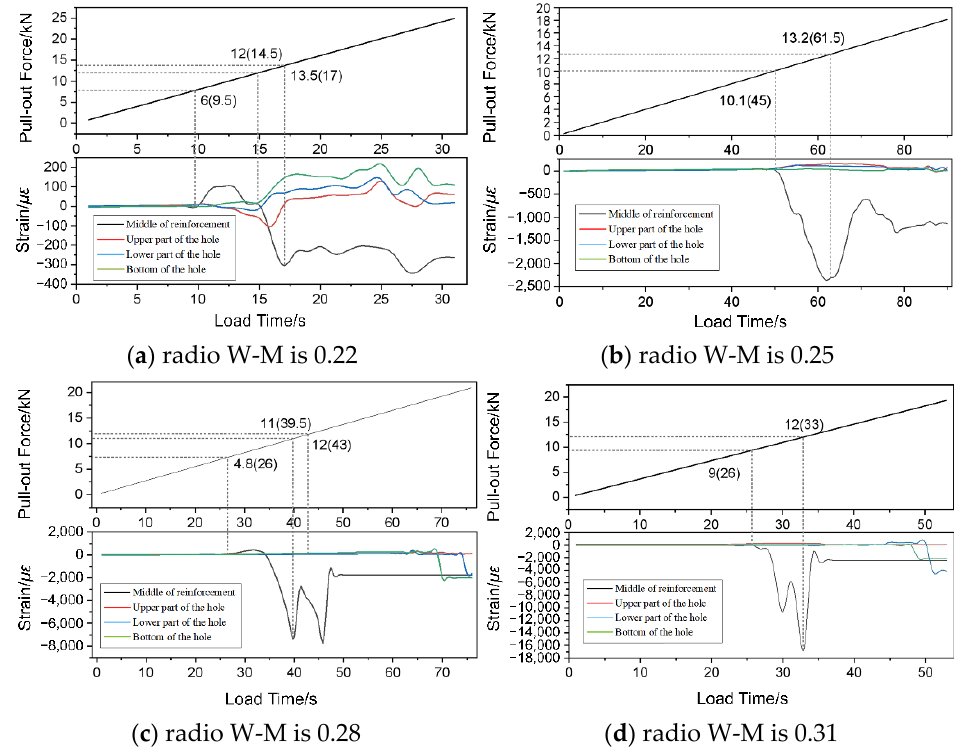
Figure 11. Drawing strain under different water–material ratio conditions.